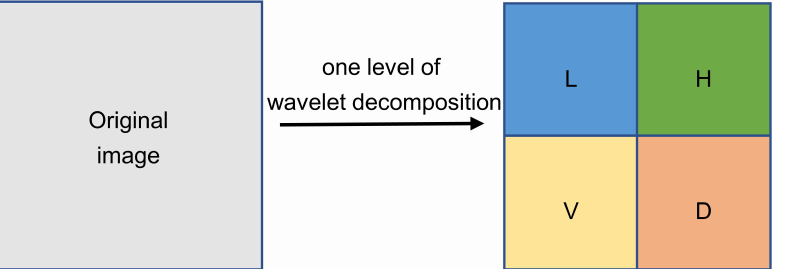
Figure 2. One level of wavelet decomposition. L, H, V, D represent low-frequency coefficient, horizontal high-frequency coefficient, vertical high-frequency coefficient and diagonal high-frequency coefficient.